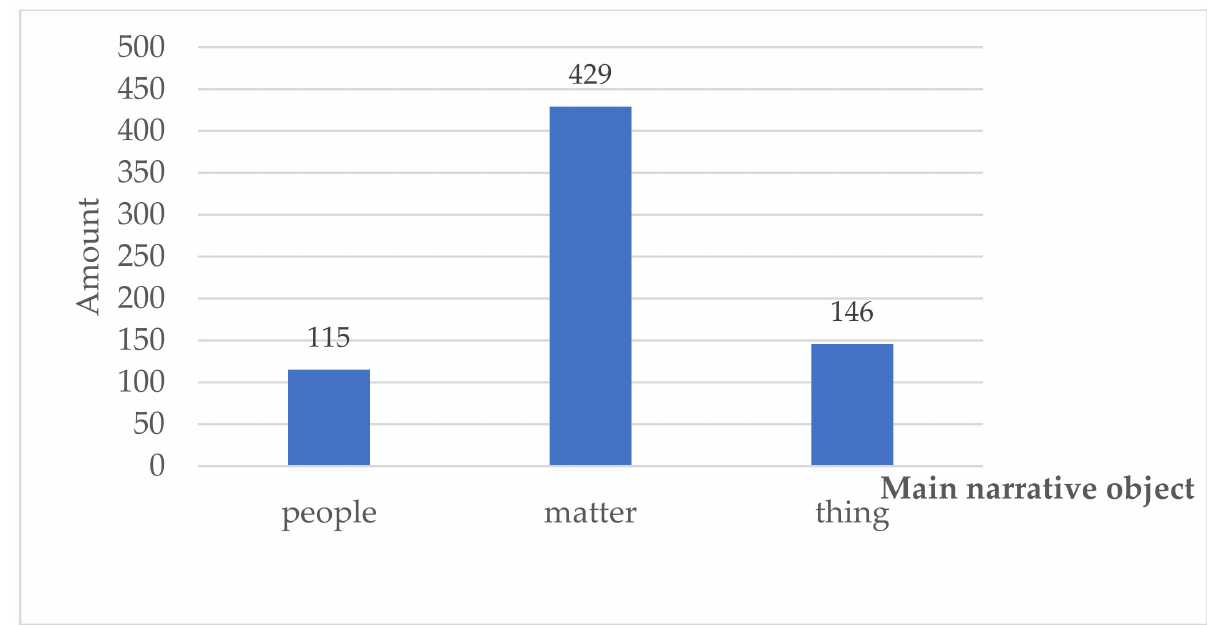
Figure 7. Clustered histogram of the main narrative object of YiXi